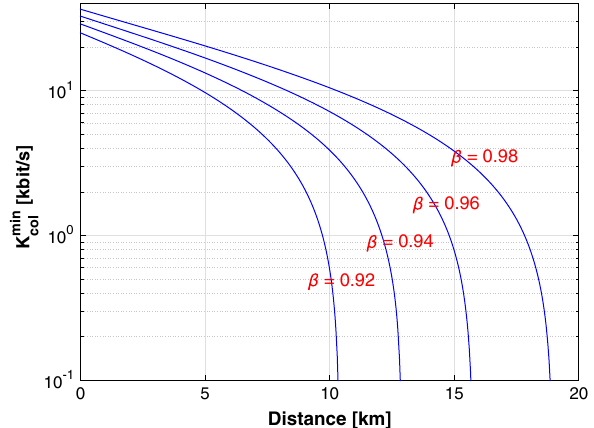
FIG. 9. Expected key rates as a function of transmission distance for the current experimental setup and a range of postprocessing efficiency values ( β ). The parameters used are V 34 , V 900 , δ 0 , ϵ ¼ 0 . 01 , V 0 . 01 , and pulse A ¼ R ¼ R ¼ el ¼ rate of 250 kHz. The homodyne efficiency was taken to be the average value (this quantity fluctuates in our setup — see main text) of η ¼ 0 . 719 . The transmission loss was taken to be 0 . 2 dB =